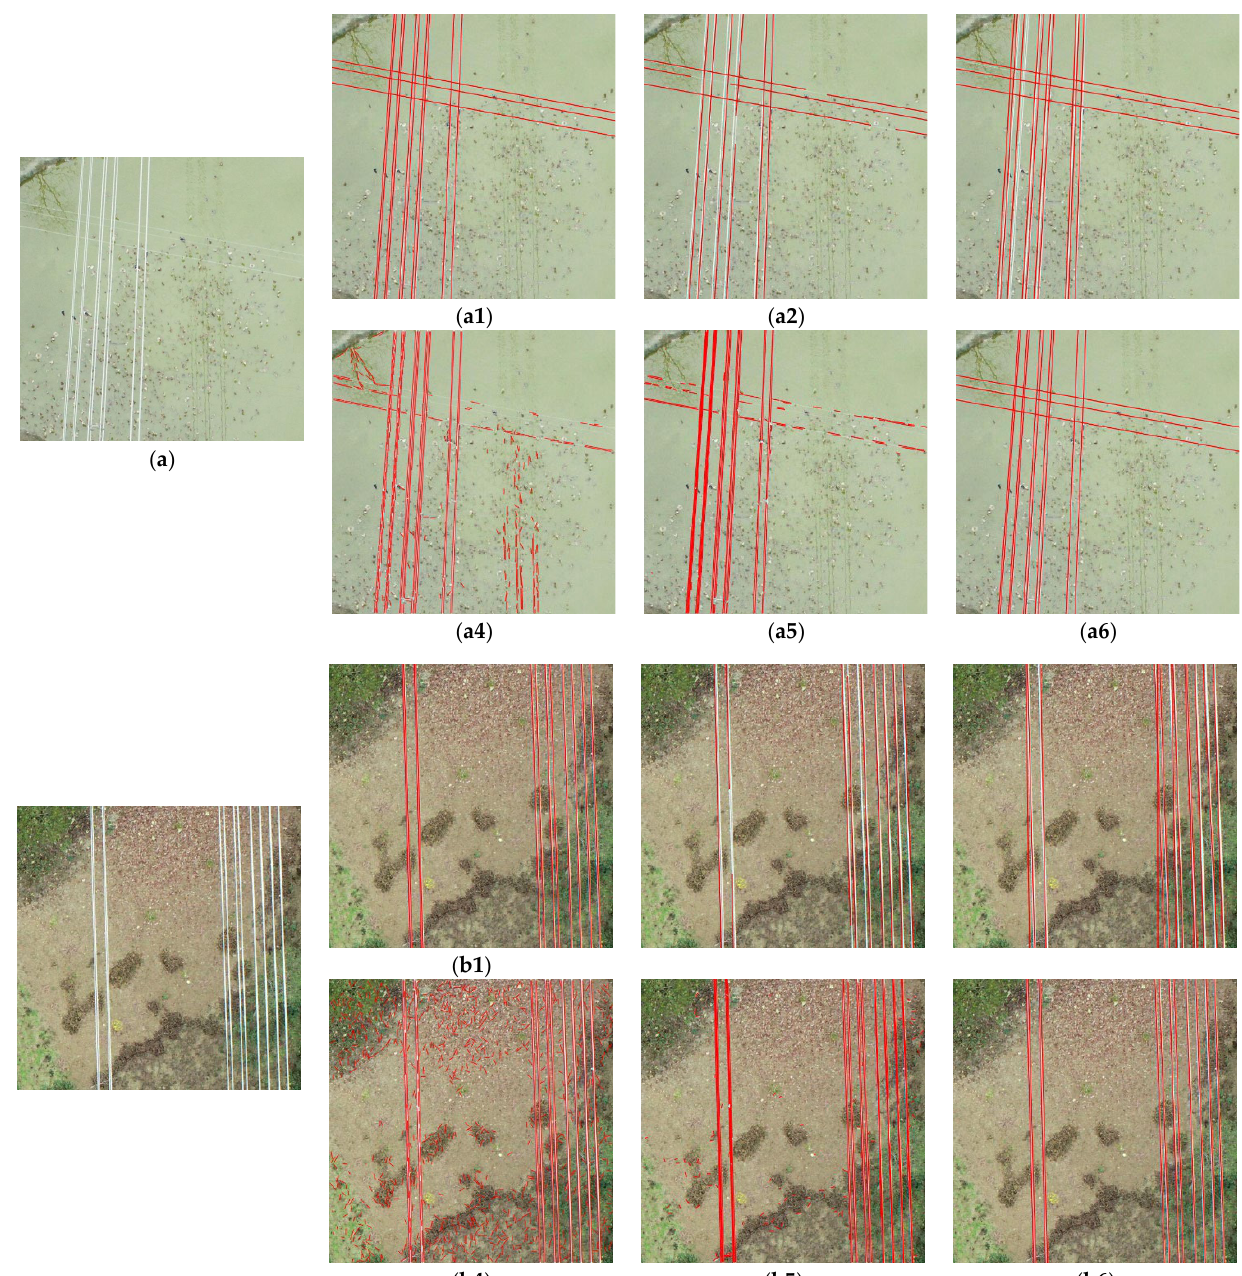
Figure 14. Extraction results for low IC images: ( a , b ) are the original images; ( a1 , b1 ) are the ground truth; ( a2 , b2 ) are the results of the IHT method; ( a3 , b3 ) are the results of the CRT method; ( a4 , b4 ) are the results of the OLSD method; ( a5 , b5 ) are the results of the LSD-OMRF method; and ( a6 , b6 ) are the final fitting results of the method proposed in this paper.